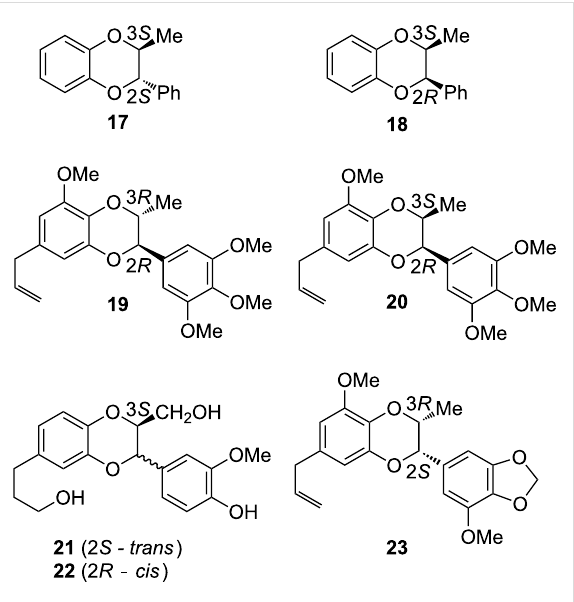
Figure 5: Synthetic and natural (benzodioxane-type) compounds related to silybin stereoisomers with known absolute configurations.